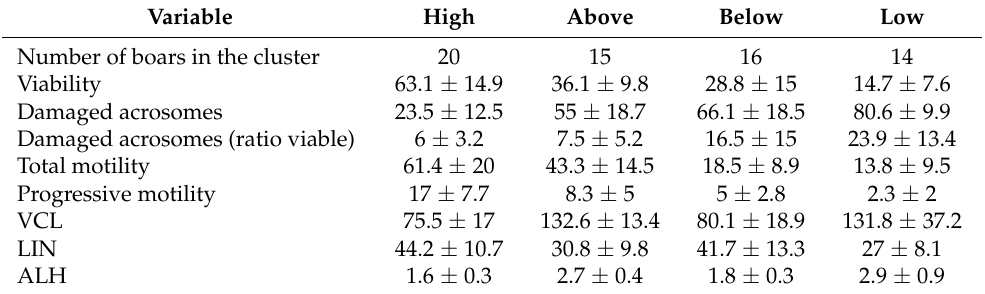
Table 1. Descriptive statistics (mean ± standard deviation (SD)) for the boar clustering according to the resistance of their spermatozoa to the cold-shock ( n =